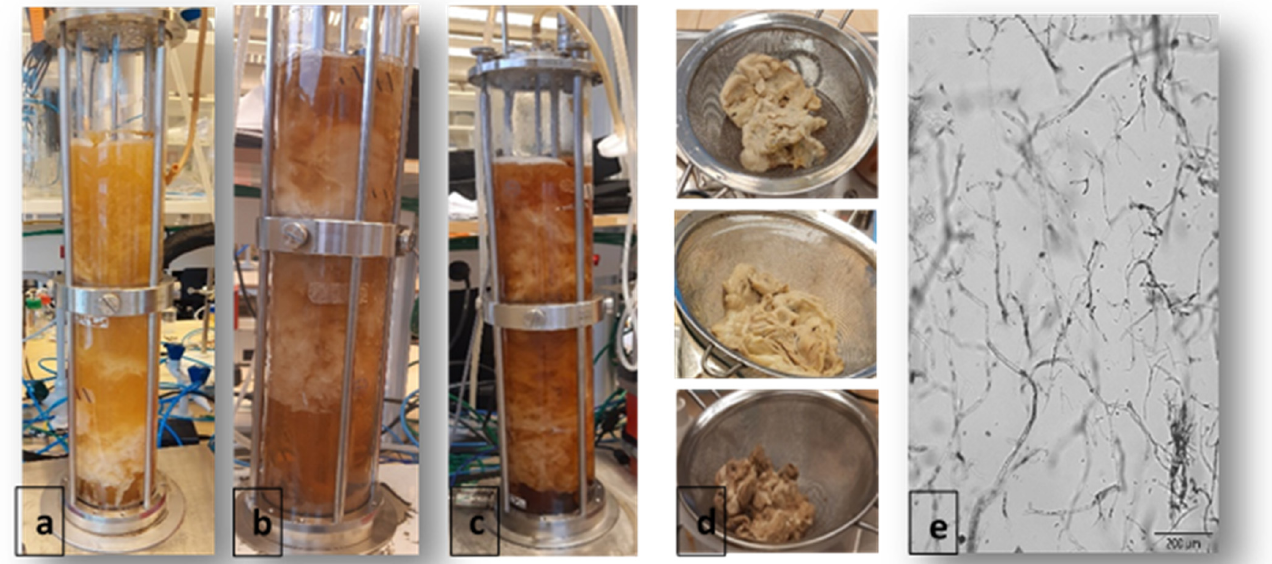
Figure 3. ( a – c ) Fungal cultivation in bubble column bioreactors using LFCP after the hemicellulase, pectinase, and invertase pretreatments, respectively; ( d ) harvested biomass from the hemicellulase ( top ), pectinase ( middle ), and invertase ( bottom ) pretreatments; ( e ) fungal mycelium obtained after the hemicellulase pretreatment (image was captured by oCelloScope).